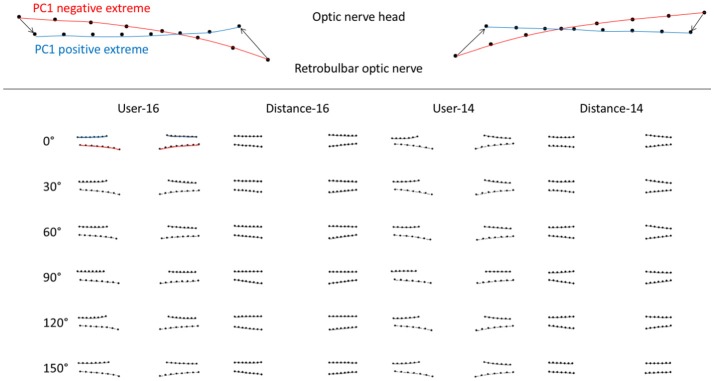
Scan angle specific first principal components of peripapillary Bruch's membrane shape according OCT acquisition pattern (scan angle, rows) and image analysis strategy (columns) calculated using geometric morphometric analysis. Upper image is an example of a first principal component of pBM shape. The red curves represent the negative extreme (−1) of the PC and the blue curves represent the positive extreme (+1). The markers are the semi-landmarks for that extreme. The arrows between semi-landmarks (only 4 shown for simplicity) are the trajectories of semi-landmarks for the PC illustrated. Images in the table shows pBM shapes for the extreme negative (lower) and positive (upper) magnitudes of PC1 for images taken at a particular scan angle (row) and analyzed using a particular strategy (column).